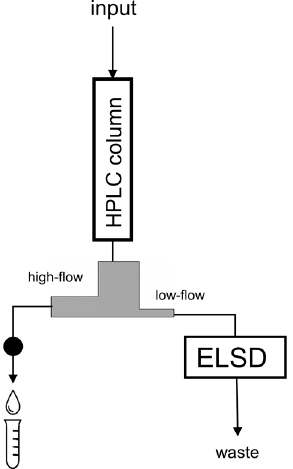
Figure 1. The set-up for collecting the fraction with an ELSD. The splitter is the grey segment connected below the HPLC column (high-flow and low-flow outlets are denoted); the black circle represents a UV detector monitoring salicin (for comparison purposes).